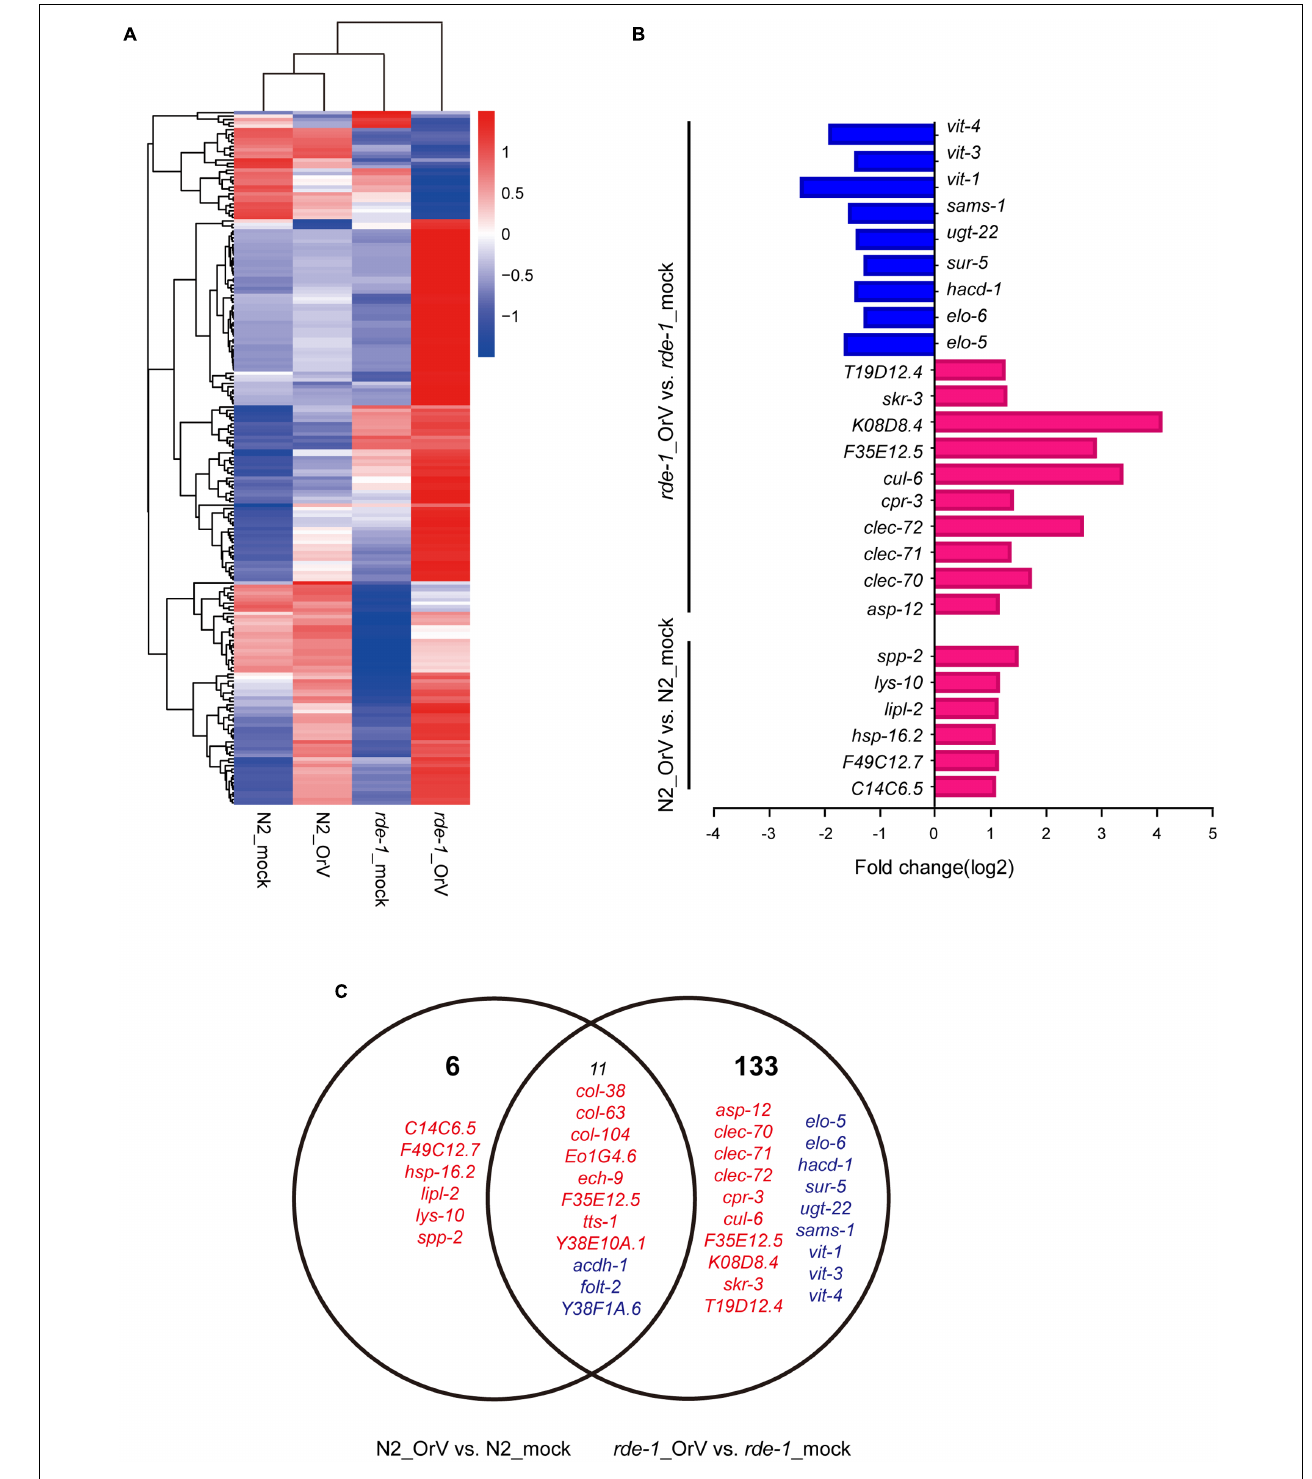
FIGURE 5 | Changes in gene expression upon viral infection. (A) The heatmap shows all the genes that changed by more than twofold after infection ( t -test < 0.05). Each row shows a different gene. Blue, white, and red indicate expression levels of low, medium, and high gene values, respectively. (B) Gene ontology (GO) and pathway enrichment analysis of predicted targets by differentially expressed mRNAs. Red indicates increased gene expression while blue indicates decreased. (C) The Venn diagram displaying the total number of genes significantly up-and downregulated after Orsay virus-infection in N2 and rde-1 ( ne219 ) mutant samples. Red indicates increased gene expressions, while blue indicates